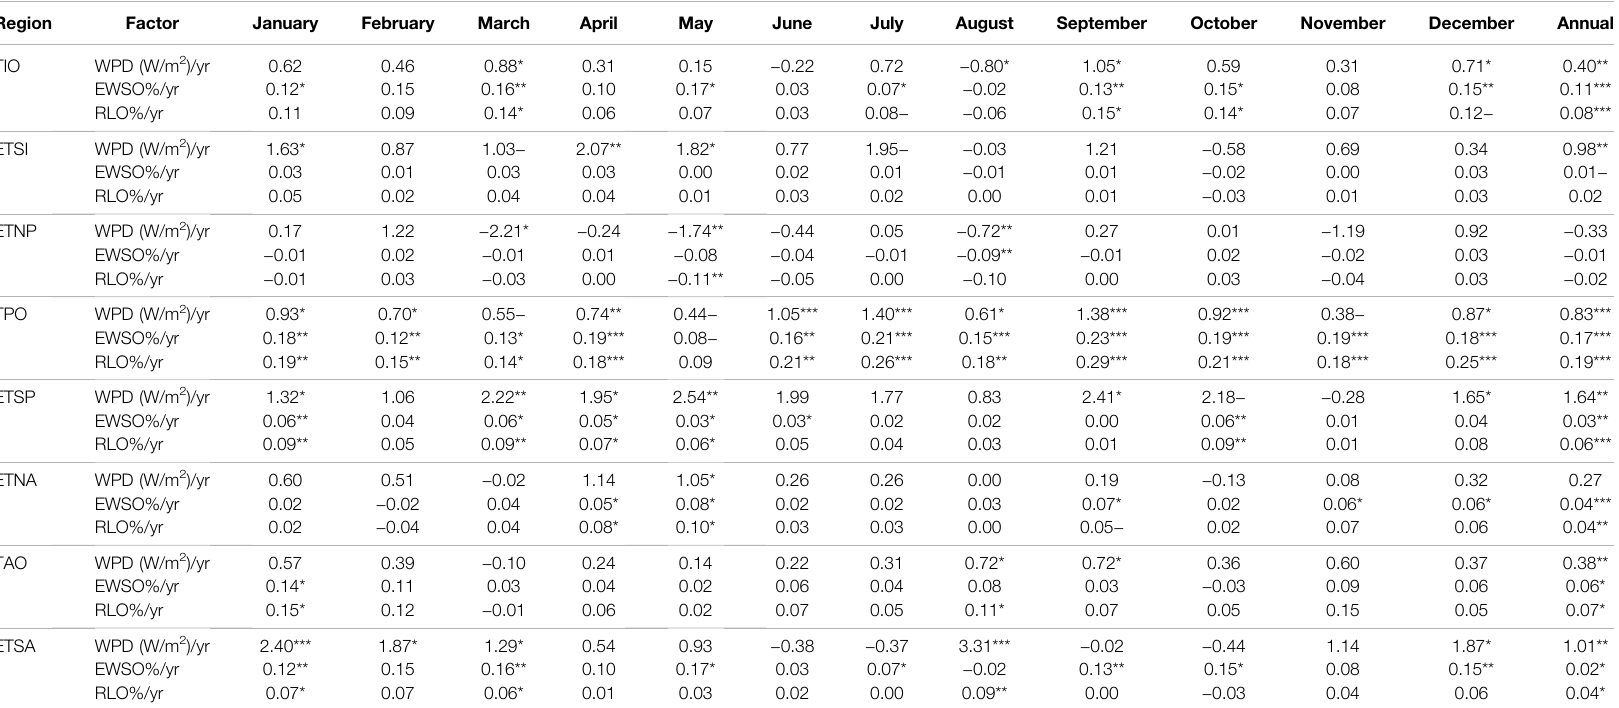
TABLE 1 | Climatic trends of WPD, EWSO, and RLO in several key regions. Region Factor